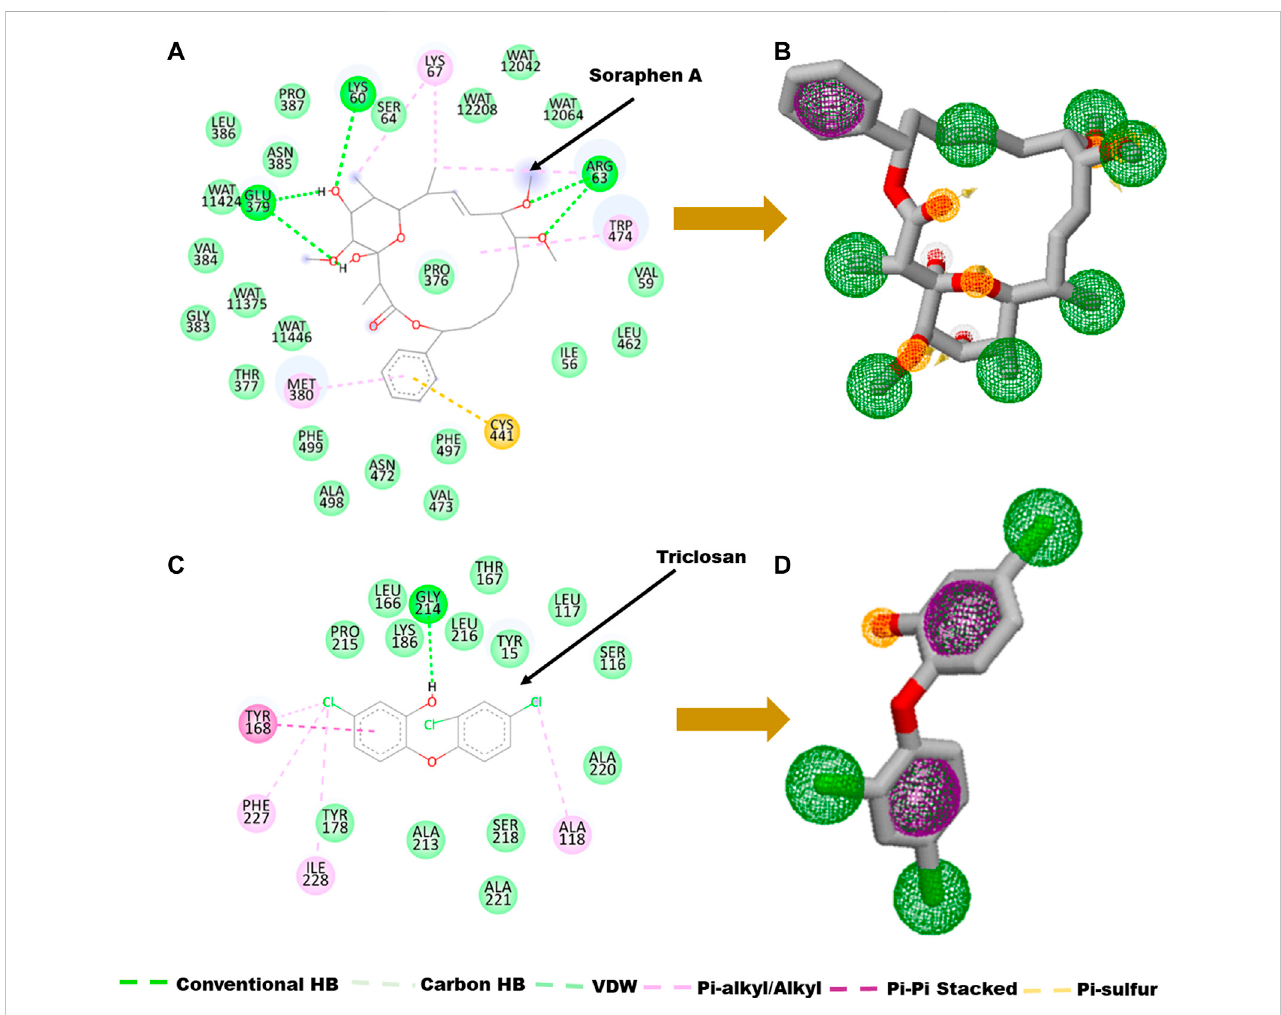
FIGURE 2 Ligand-residueinteractionplotof (A) SoraphenAatthebindingsiteofacetyl-coenzymeA(CoA)carboxylaseenzymeand (C) Triclosanatthebindingsite of enoyl-acyl carrier reductase. (B – D) Generated pharmacophores showing aromatic (green) and hydrophobic moieties (Purple) and hydrogen donors